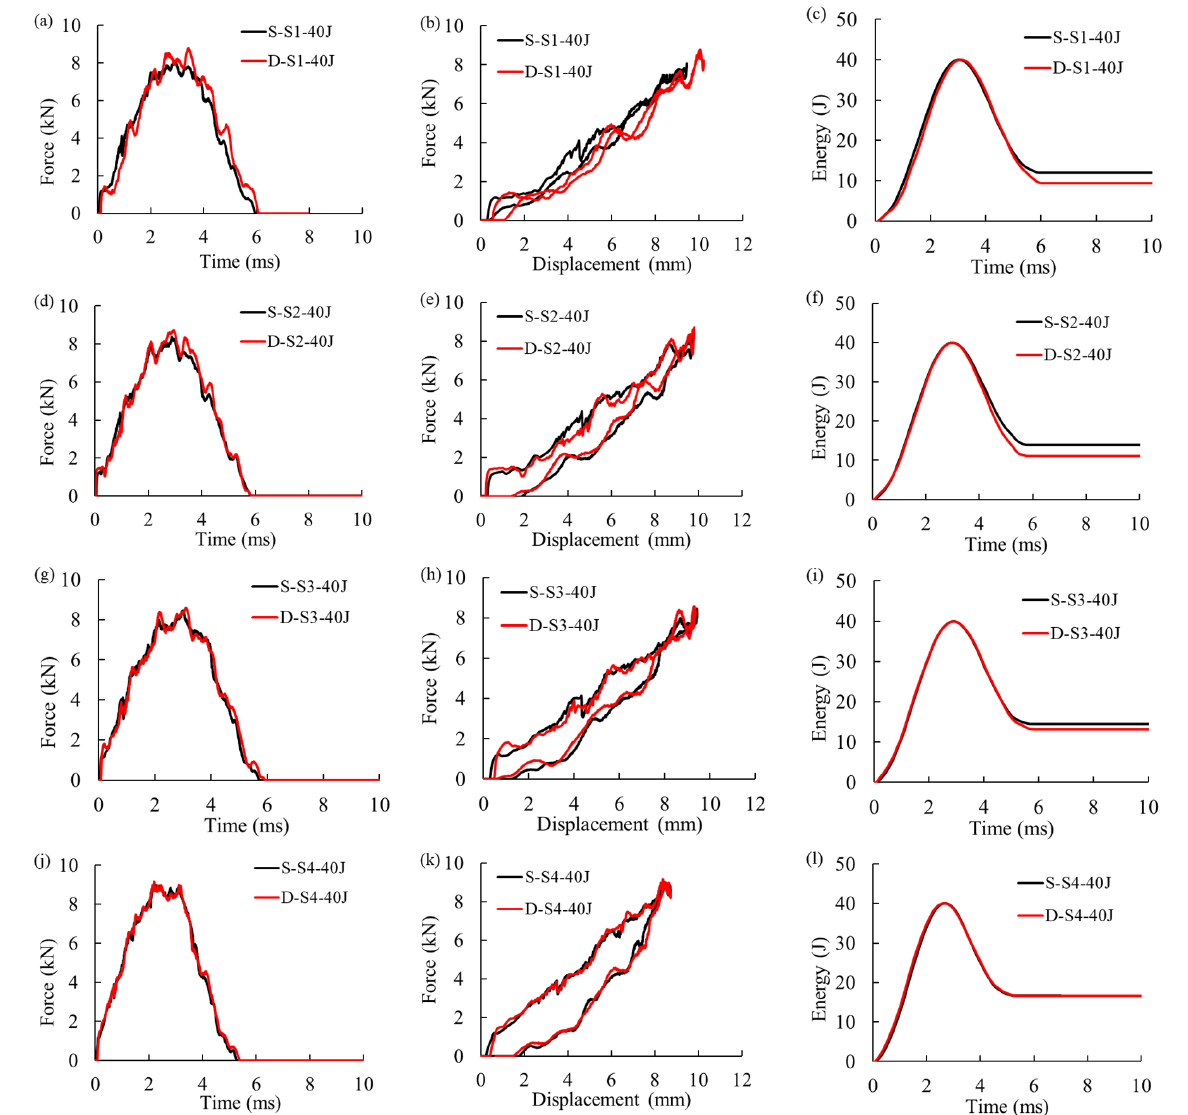
Figure 9. Comparison of force–time, displacement–time, and energy–time curves between a single and a double 40 J low ‐ velocity impact at: ( a – c ) S 1 , ( d – f ) S 2 , ( g – i ) S 3 , and ( j – l ) S 4